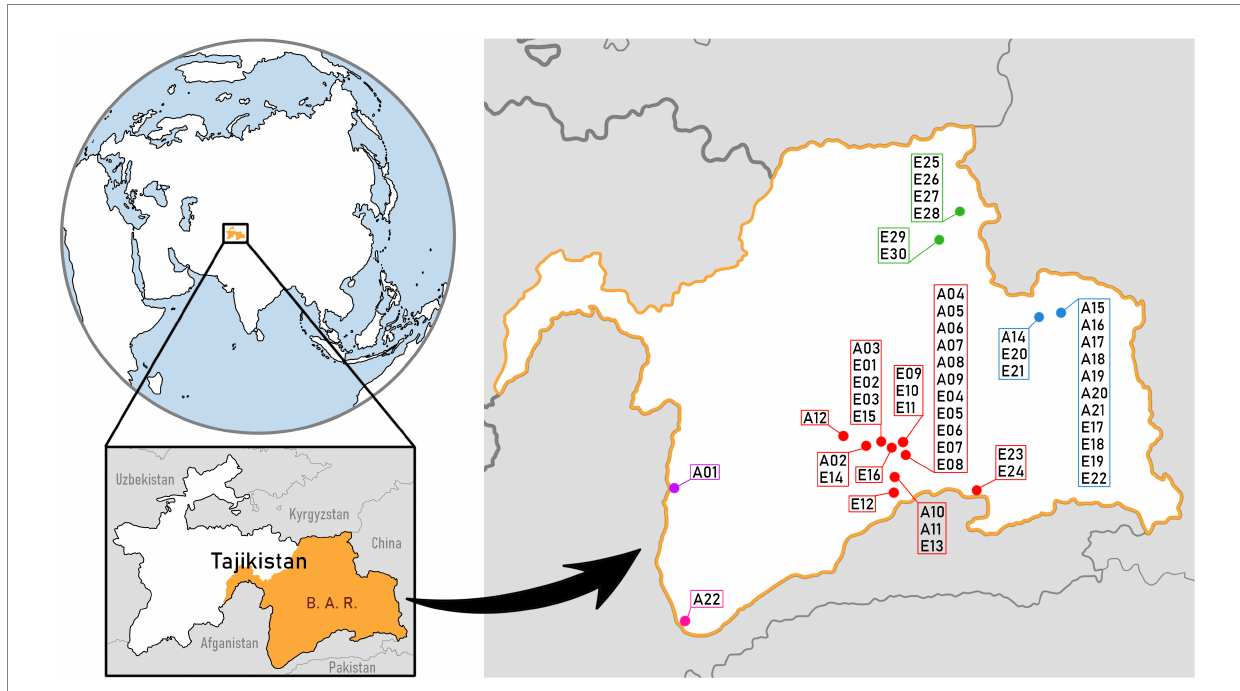
FIGURE 1 Map of Badakhshan Autonomous Region (B. A. R. on map) in Tajikistan, Central Asia. Sample sites, along with the sample names, are marked by the subregion: Bulunkul in red color, Rangkul in blue, Karakul in green. Samples that were collected outside of the three subregions are the ones from Khorog (marked in violet) and Ishkashim (marked in pink). The map was based on public domain pictures from WikiMedia